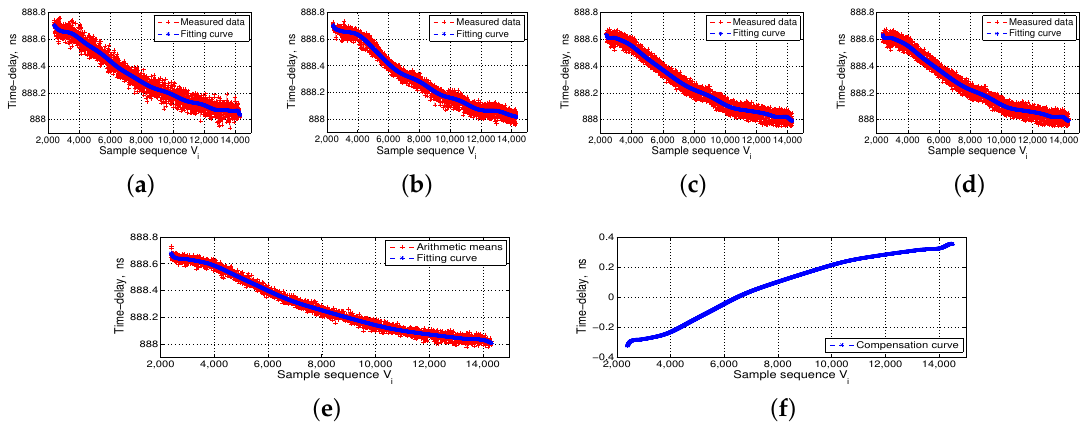
Figure 7. Digital baseband (DBD) transmission-delay measurement data preprocessing. ( a – d ) the transmission-delay data measured four times and the corresponding fitting curves; ( e ) the arithmetic means of the delay data measured four times and the corresponding fitting curves; and ( f ) the final transmission-delay compensation curves of the DBD.